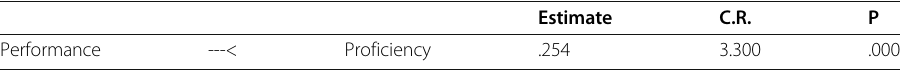
Table 8 Standardized Regression Weights: (data - Default model)